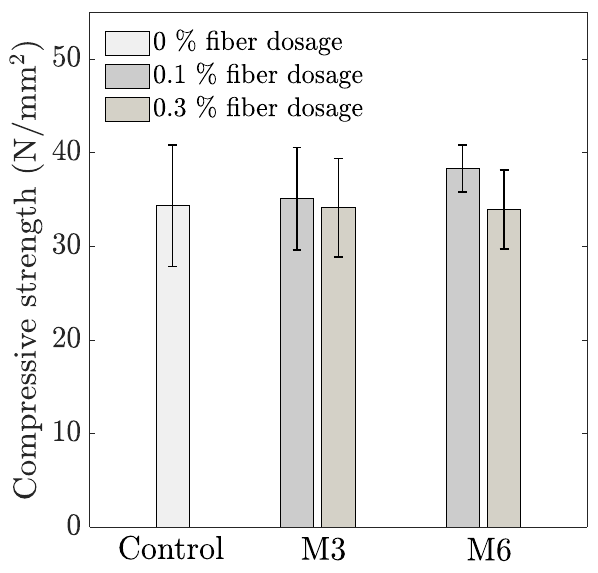
Figure 5. Influence of fiber addition on average 28-day compressive strength (error bar represents the standard deviation, n = 6).